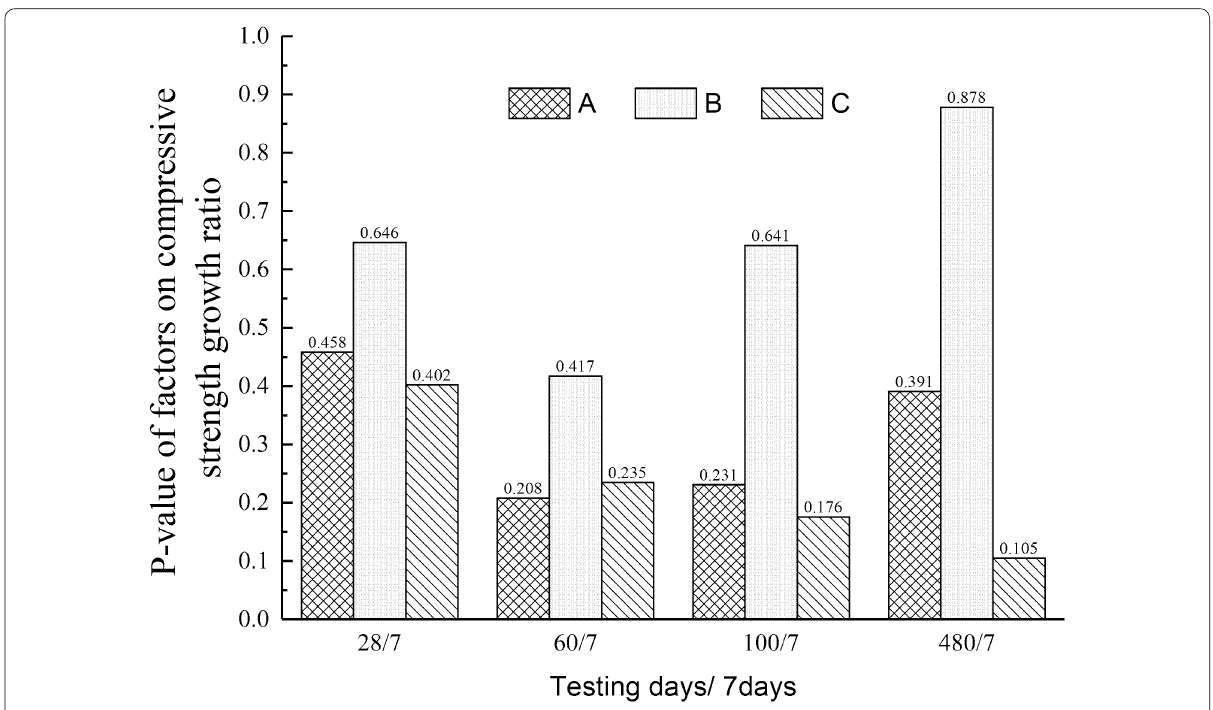
Fig. 16 P-value of various factors on strength growth ratio with regard to 7-day